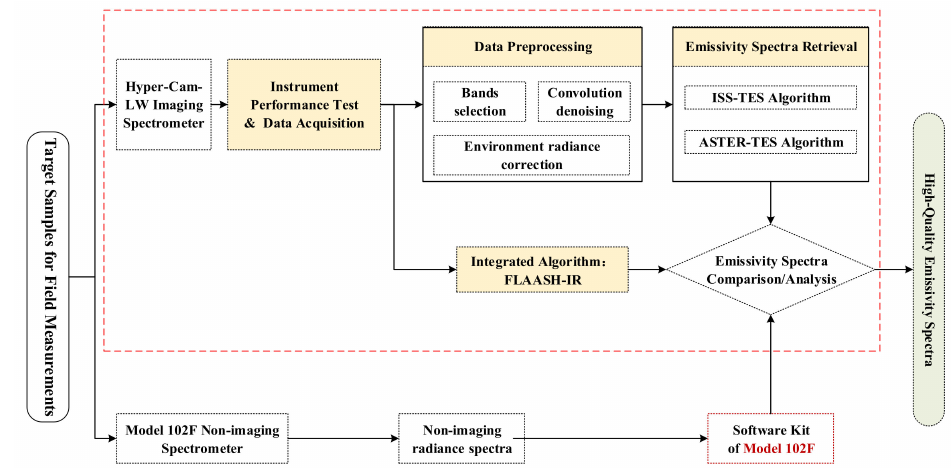
Figure 1. The framework for deriving emissivity spectra from the Hyper-Cam LW field-based